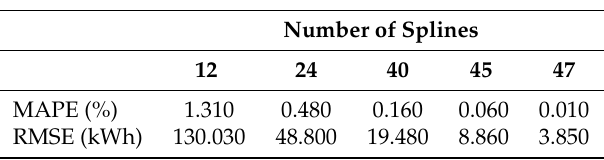
Table 6. RMSE and MAPE between the splines approximation and the electrical load data as a function of the number of splines.